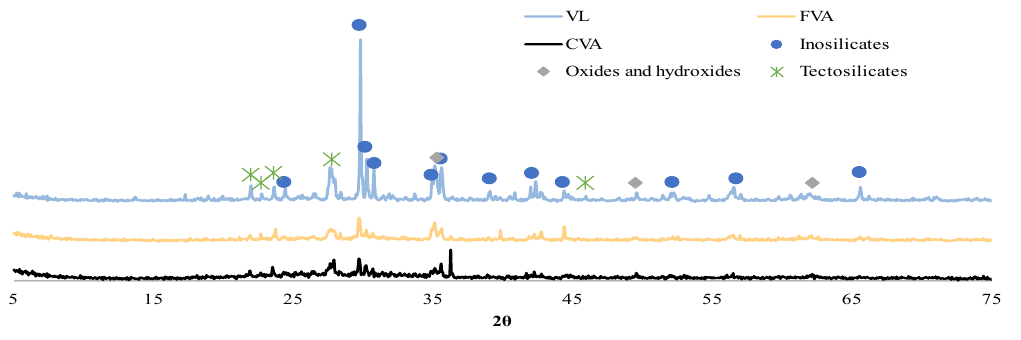
Figure 5. XRD patterns of VL, FVA, and CVA.